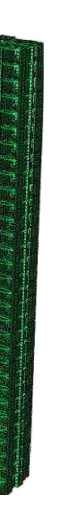
Figure 9: The assembly model of RHC shear wall structure.